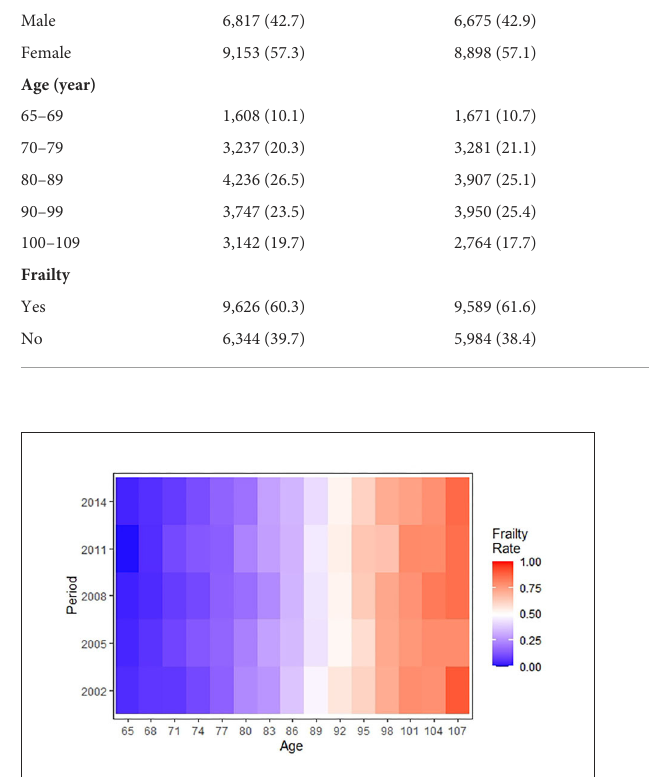
FIGURE2 A heatmap showing the age-period distribution of frailty rates among Chinese older adults during 2002–2014. data of 2002 as an example, 42.7% were men, 10.1% were 65–